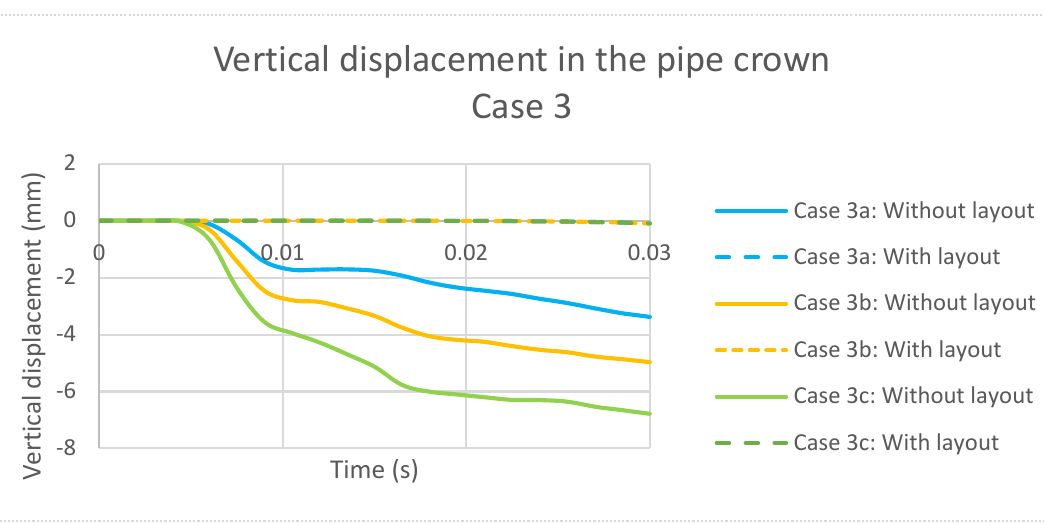
Figure 9. Vertical displacements in the pipe crown for case 3.